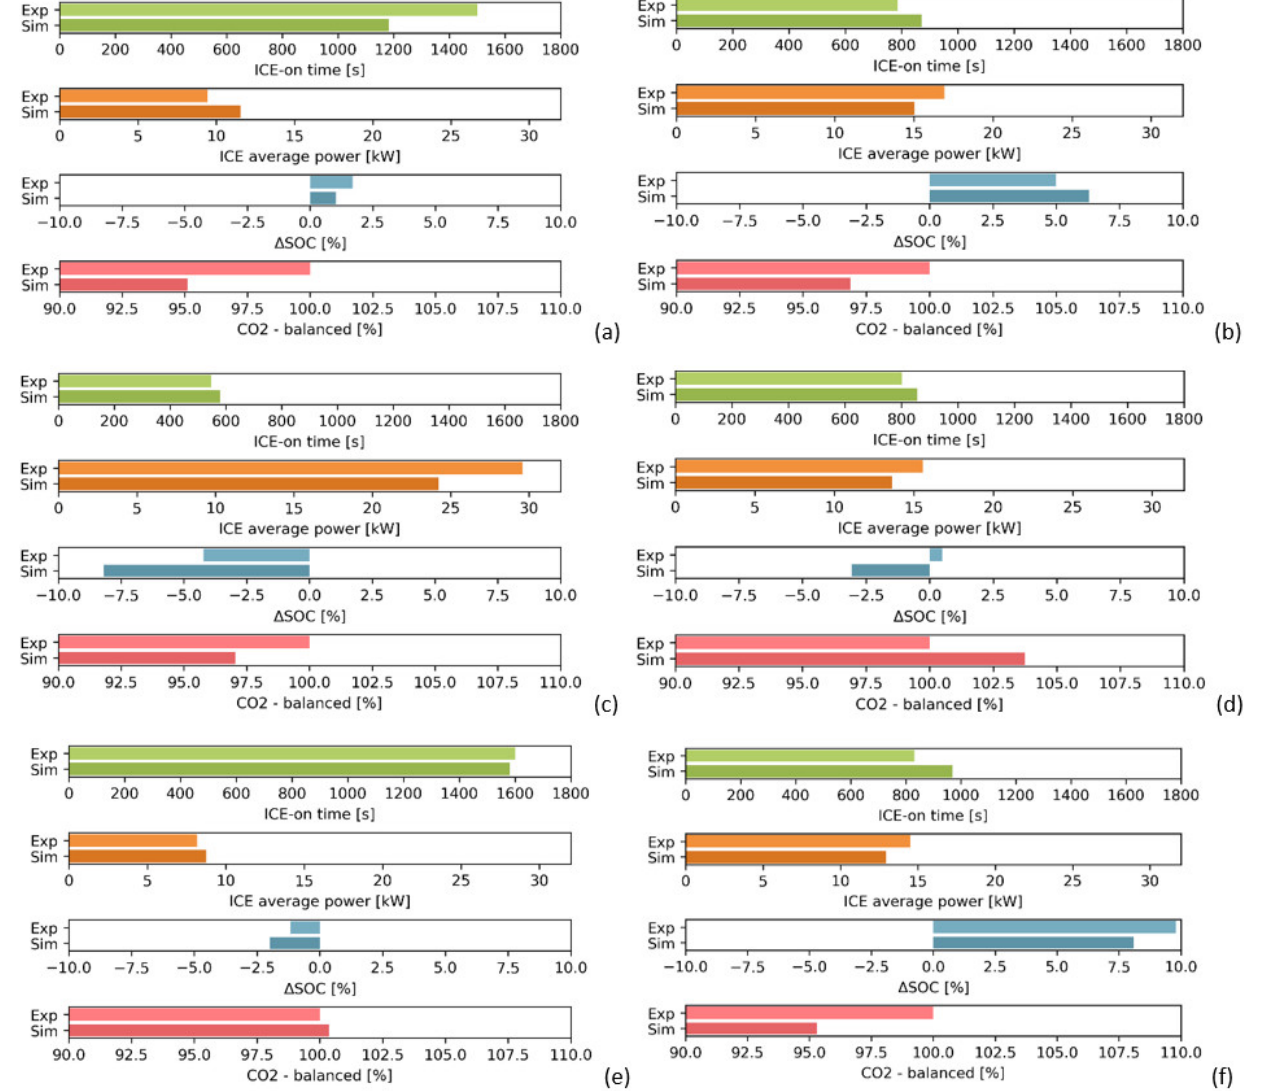
Figure 11. Simulation results for ( a ): Vehicle 1 (series REx), ( b ): Vehicle 2 (parallel full hybrid), ( c ): Vehicle 3 (series-parallel plug-in hybrid), ( d ): Vehicle 4 (parallel plug-in hybrid), ( e ): Vehicle 5 (parallel mild hybrid), ( f ): Simulation results for Vehicle 6 (power-split full hybrid). The estimation error is always within ±5%, with an average error of −1.93% and an error standard deviation of 3.07%. The underestimation tendency might be due to some inconsistency in the newly developed vehicle simulation tool, which still needs extensive testing and validation, or by component limitations not represented correctly in the powertrain model and causing more efficient—but non-feasible—operating conditions in simulation. The results are considered satisfactory, and the simulation approach possibly represents a powerful tool for calculating vehicle performance and CO 2 emissions. 3.3.3. Comparison Other CO 2 Emissions Calculation Tools To put these results into context and further discuss the designation of this work, a comparison with other tools from the literature was carried out.